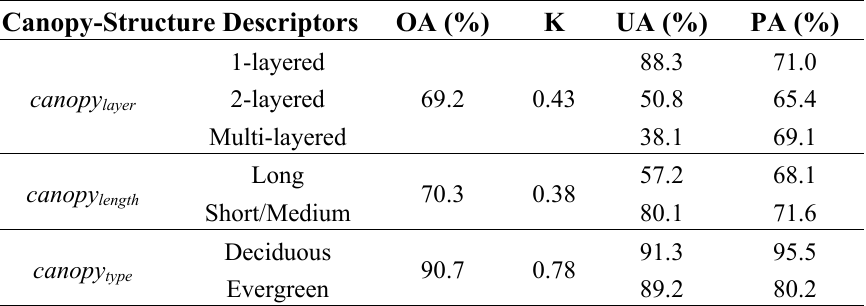
Table 4. Accuracy assessment of the canopy-structure descriptors for the whole of Canton of Aargau. We use the accuracy metrics “overall accuracy” (OA), “user’s accuracy” (UA), “producer’s accuracy” (PA), and the “Kappa coefficient” (K).